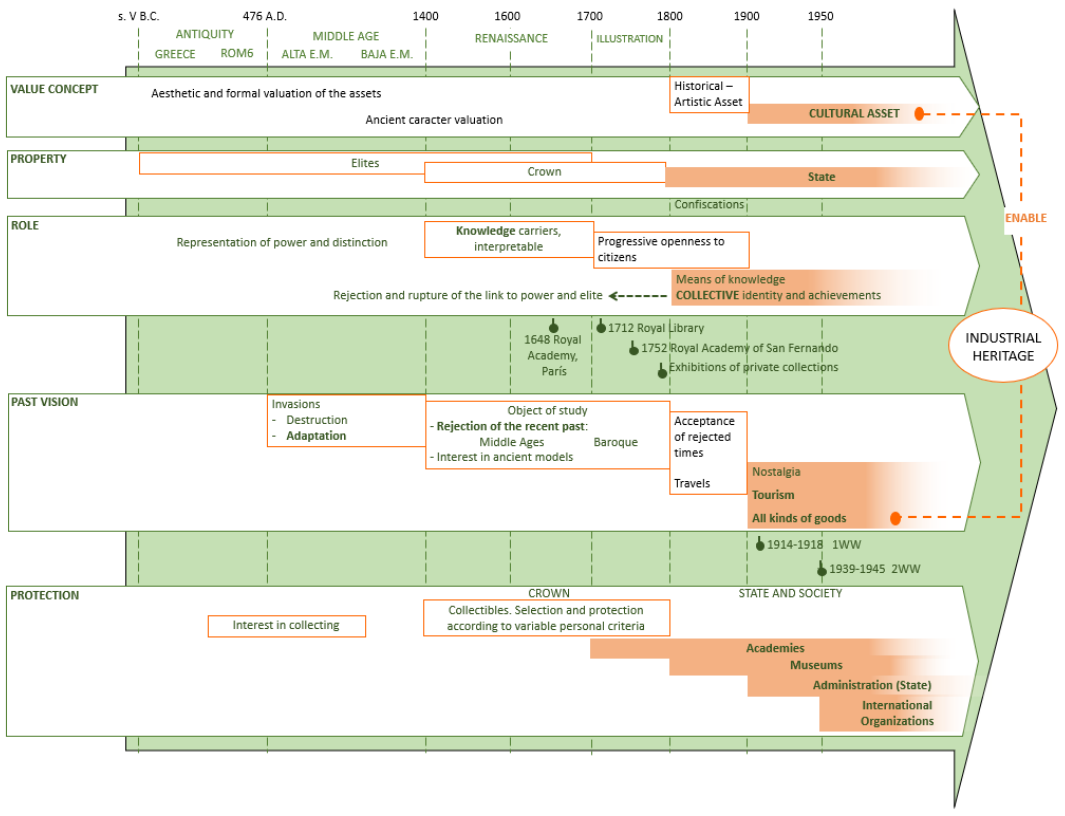
Figure 1. Heritage concept evolution [7].